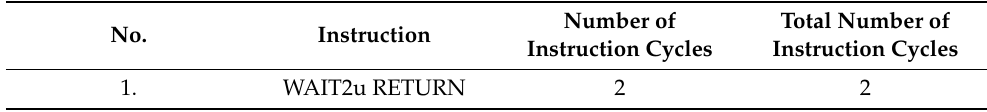
Table 2. Subroutine and duration in instruction cycles for time delay of 2 µ s.